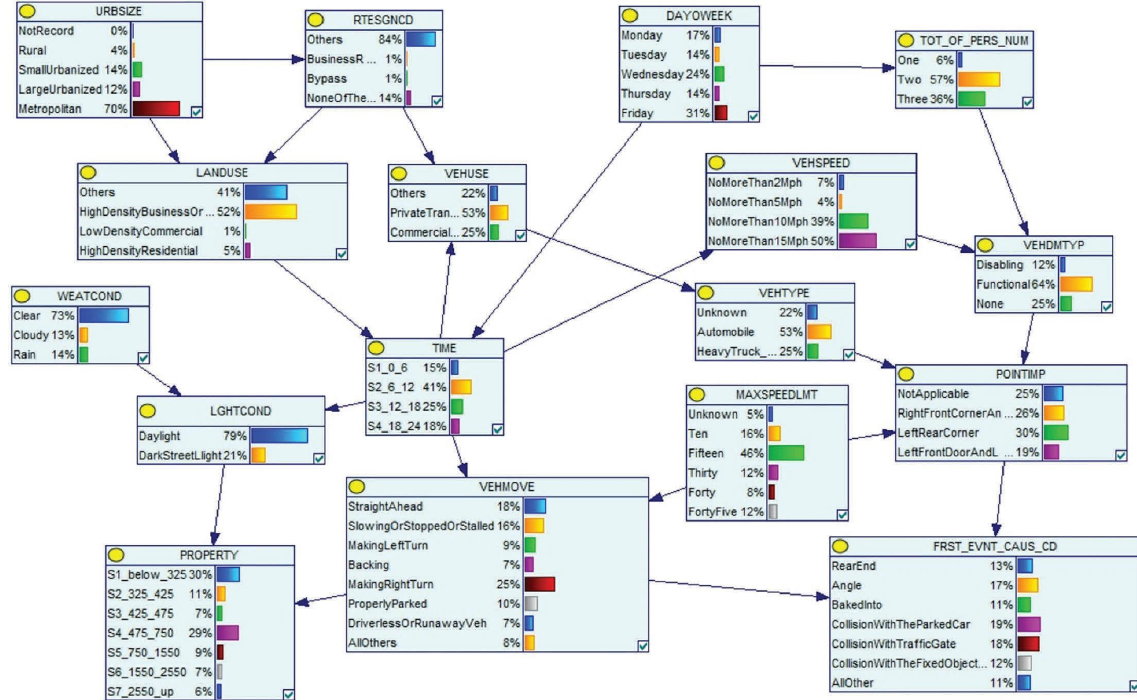
Figure 4: Te Bayesian network model after parameter learning in the GeNIe 3.0 Academic